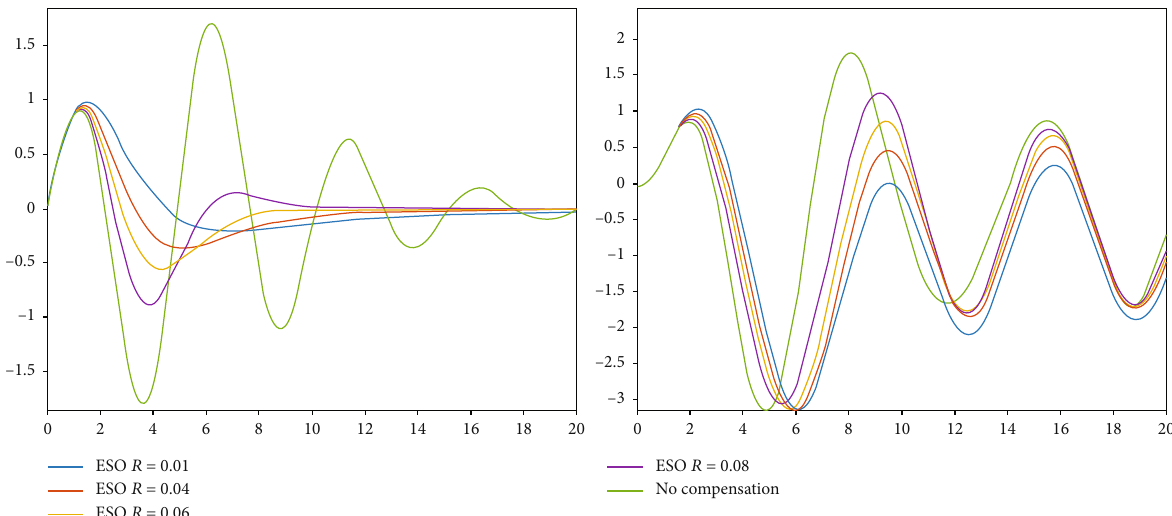
108642–2–1.5–1–0.50.511.52.5